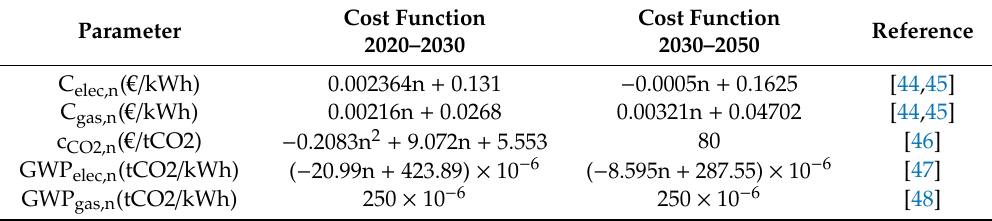
Table 3. Fuel costs, CO2 costs and